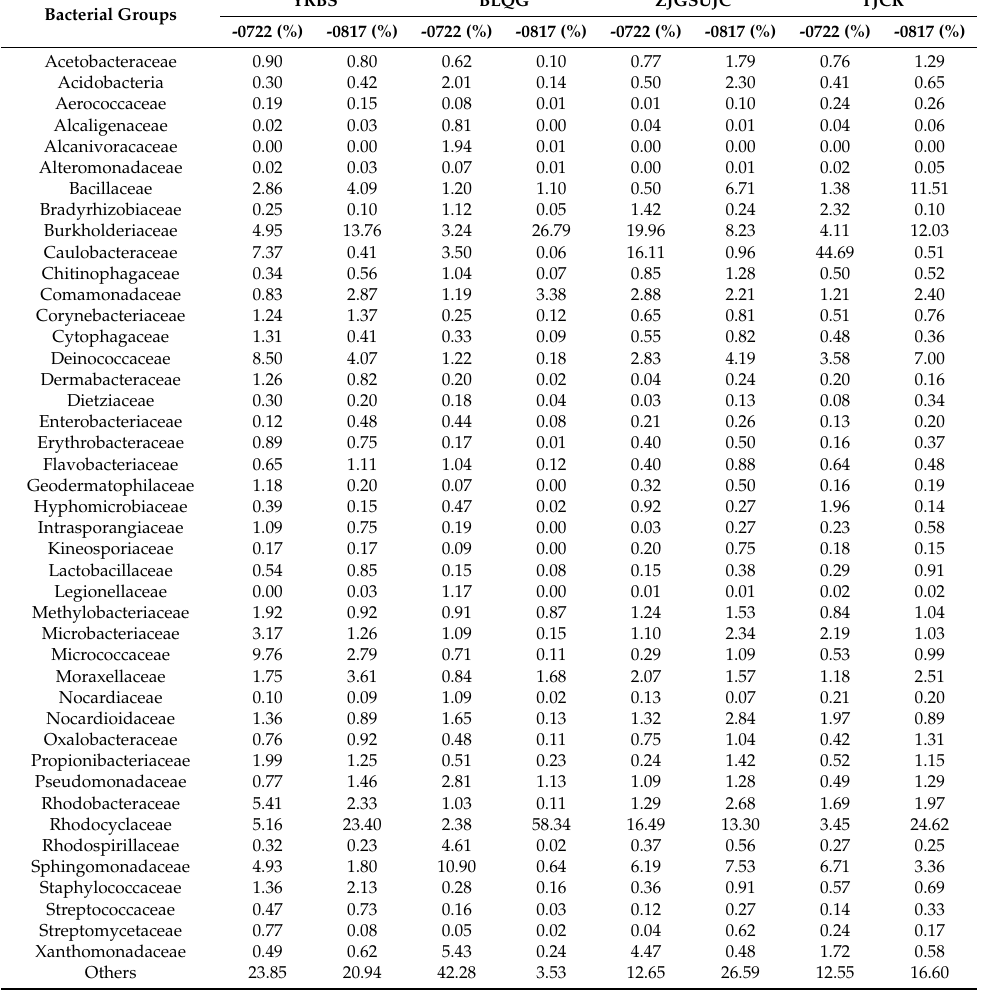
Table 2. Types and abundance of airborne bacteria at Family taxonomic levels before and after heat events. Bacterial